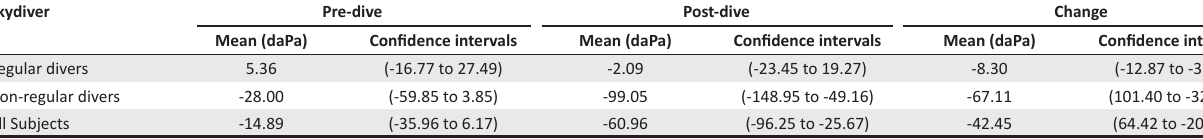
TABLE 2: Average ear pressure